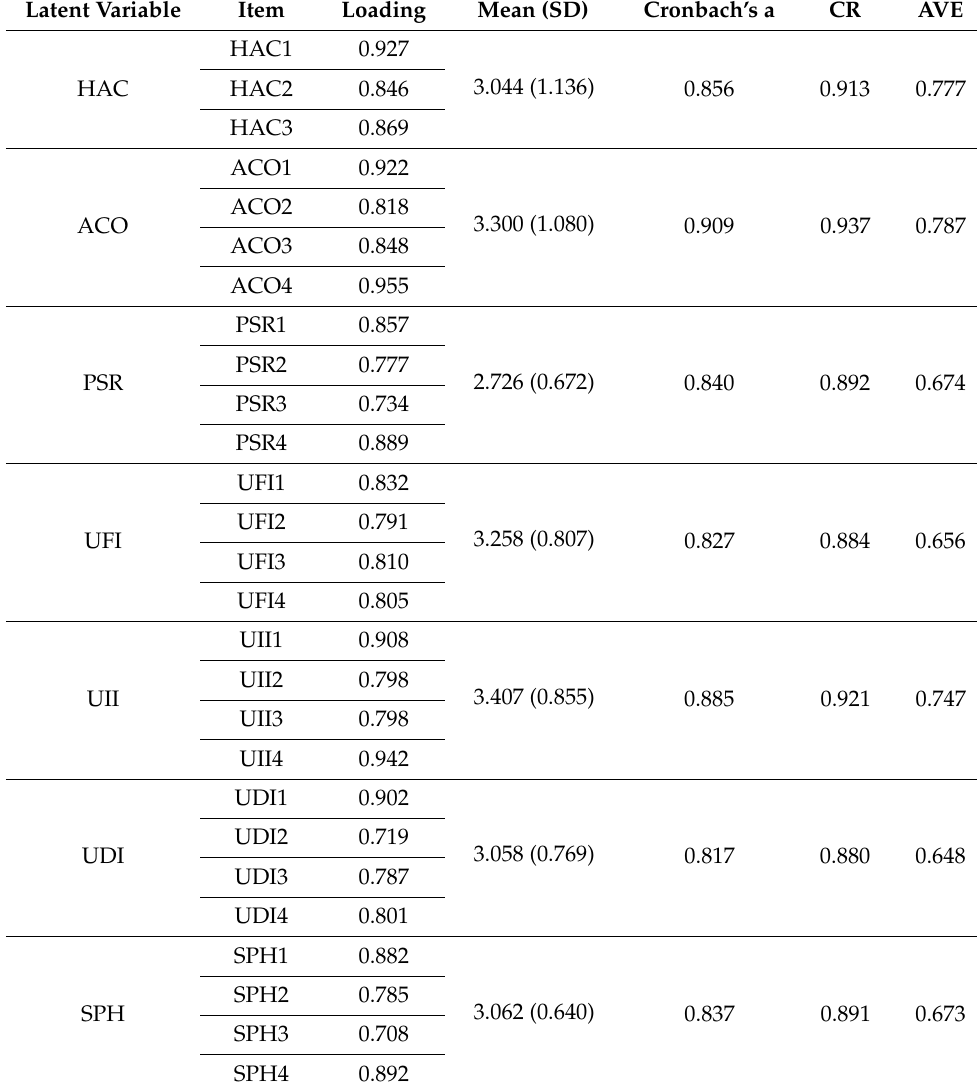
Table 3. Measurement model